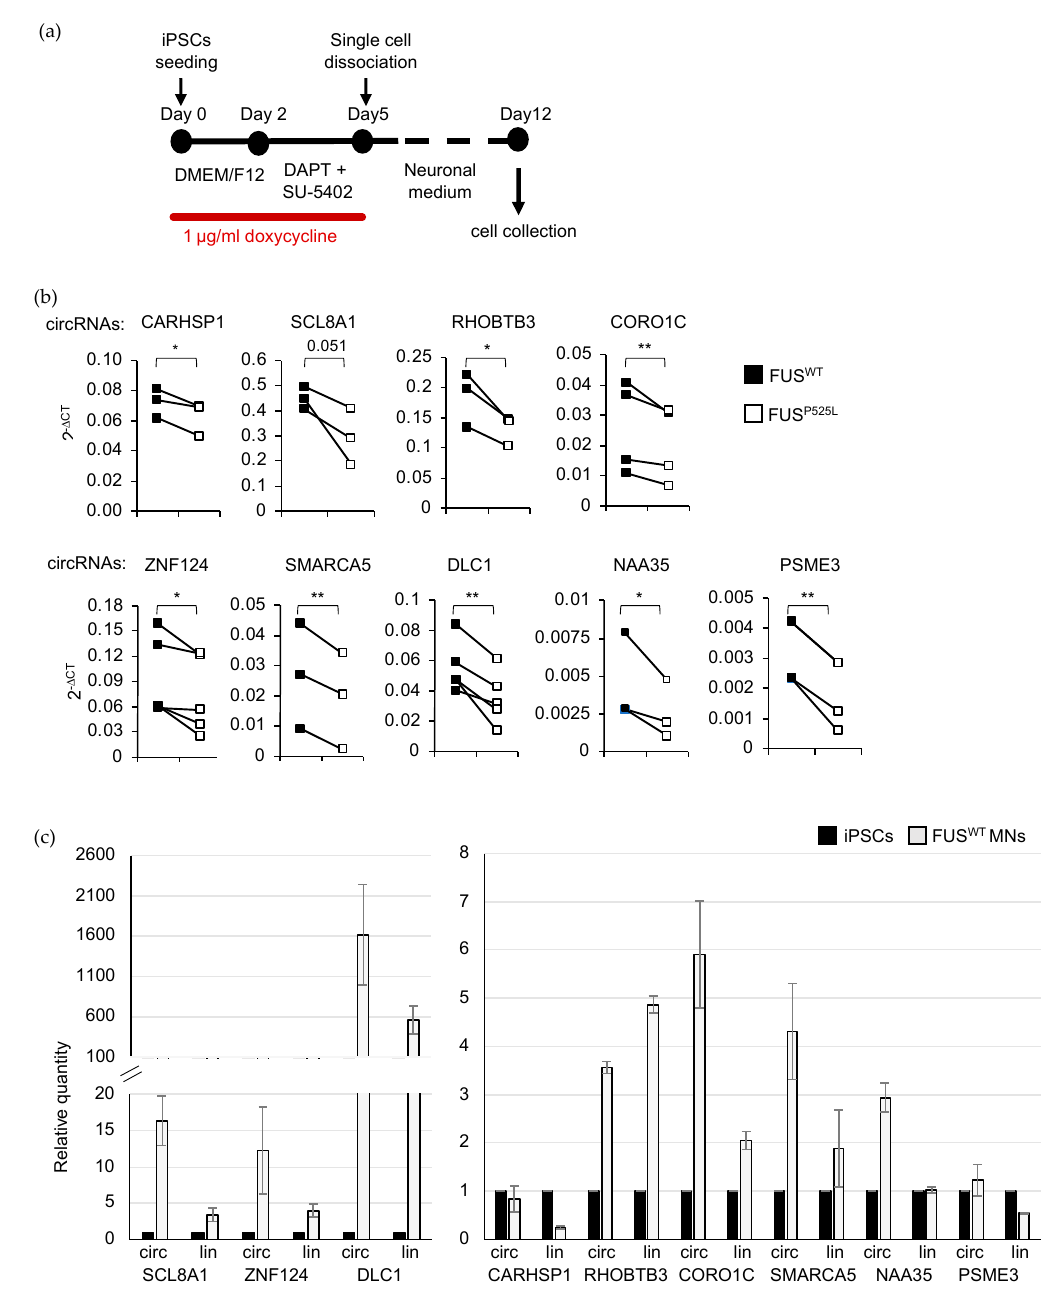
Figure 4. Validation of circRNA expression in FUS WT and FUS P525L MNs and alongside differentiation. ( a ) Schematic representation of the differentiation protocol used in this study. The medium and factors used along the timeline (day) of differentiation are indicated in the boxes while the red line depicts the duration of the treatment with doxycycline. The timing of MN collection for further analyses is also indicated. ( b ) Plots showing the levels of the indicated circRNAs measured by quantitative Real-Time PCR in FUS WT and FUS P525L MNs collected at day 12. CircRNA levels were quantified using ATP5O mRNA levels as reference and expressed as 2 ^-DCT. Values from all the biological replicates ( n ≥ 3) are shown. p -values were calculated using paired one-tailed Student’s t - test (* p < 0.05 and ** p < 0.01). ( c ) Bar plot showing the levels of the indicated circRNAs measured by quantitative Real-Time PCR in iPSCs and FUS WT MNs collected at day 12. CircRNA levels were quantified using ATP5O mRNA levels as reference and expressed as relative quantity with respect to iPSC samples set to a value of 1. Error bars represent s.d. of two independent experiments.